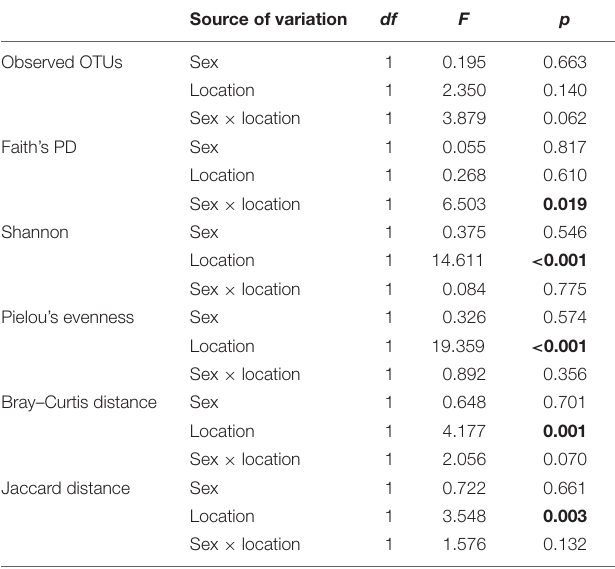
TABLE 1 | Two-way (sex and location) ANOVA and PERMANOVA on α and β diversity indices (i.e., Bray–Curtis and Jaccard distance matrices of rarefied OTU table, permutation number =